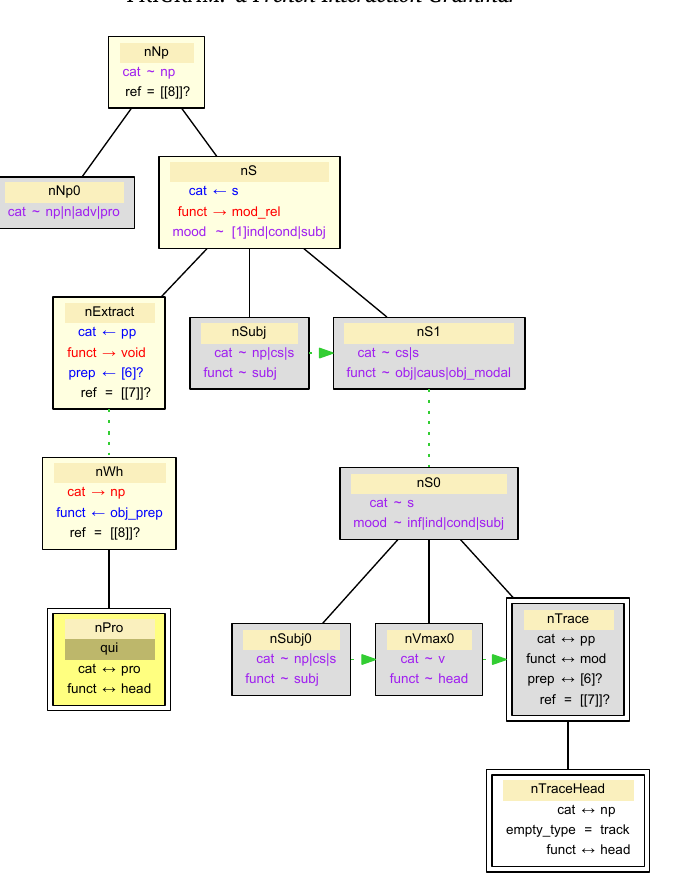
Frigram: a French Interaction Grammar